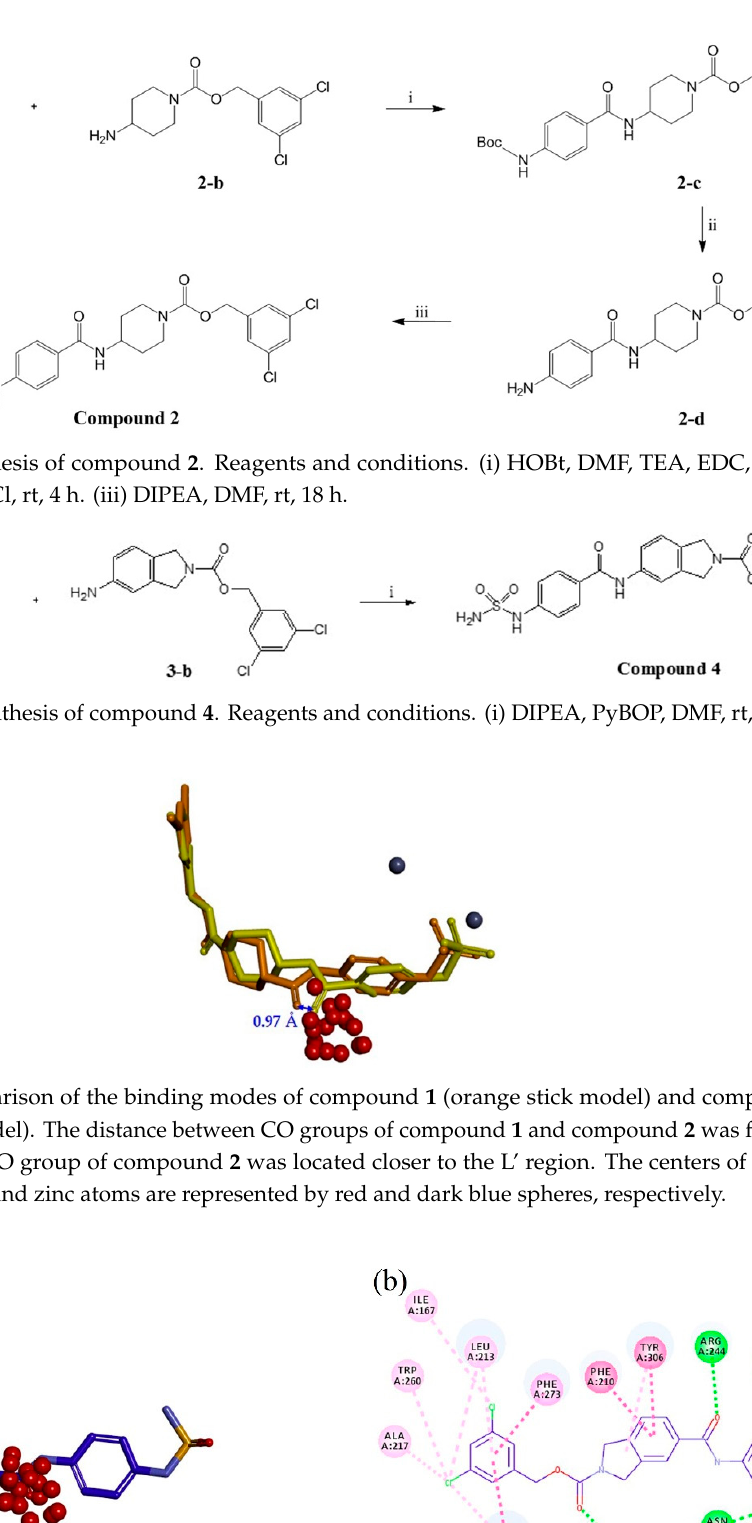
Figure 5. ( a ) Binding mode of compound 3 (cyan stick model) overlapped with TWNs of the L’ region. ( b ) 2D interaction diagram of compound 3 (purple line model). Hydrogen bond, pi-anion and hydrophobic interactions with the active site residues are shown as green, orange and pink dashed lines, respectively. The electrostatic interaction with a catalytic zinc ion is represented by the gray dashed line. We interchanged NH and CO positions of compound 3 to design compound 4 . As shown in Figure 6, compound 4 was able to form a hydrogen bond with Arg244 in the docking results. However, it may not be as strong as compound 3 due to a slight change in CO position and orientation. Also, docking results suggested a slight change in the interactions of the head region.